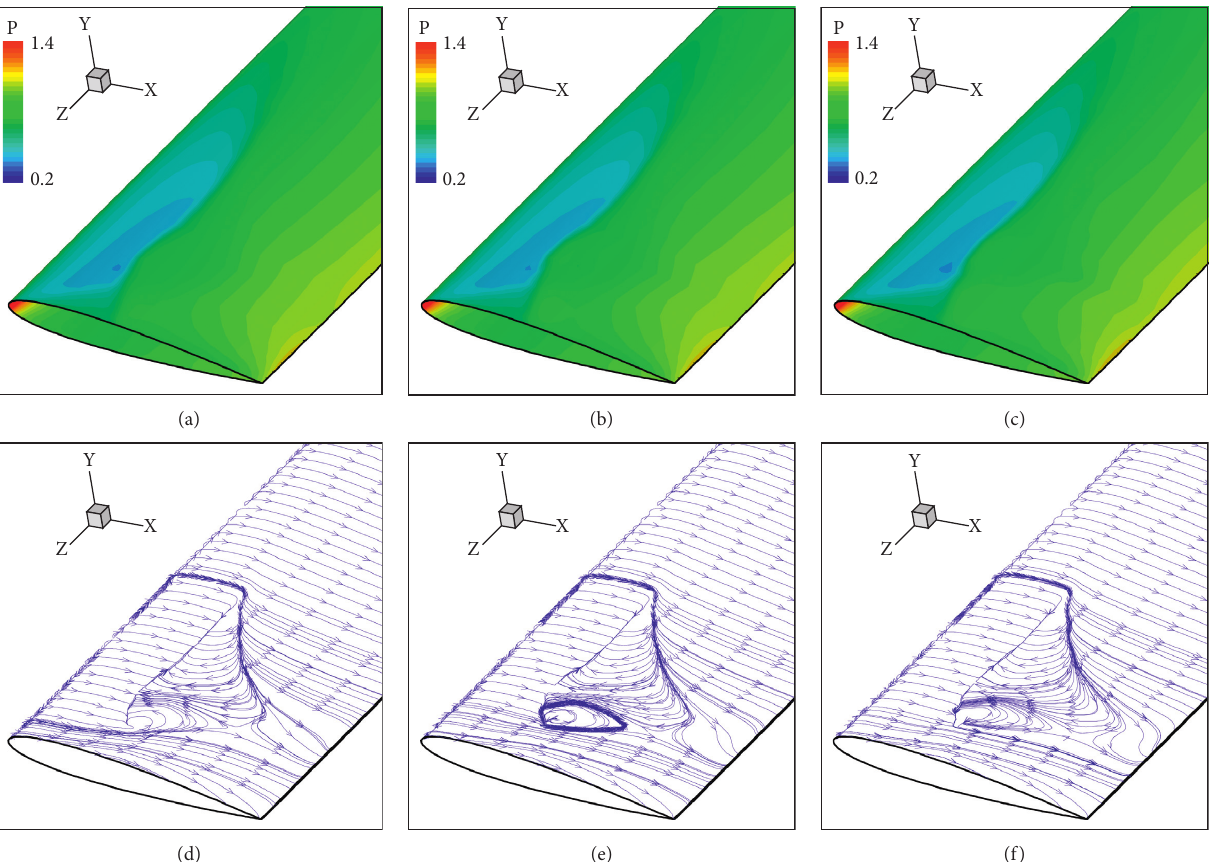
Figure 18: Pressure contours and streamlines with three WENO schemes on the blade surface for the Caradonna-Tung rotor. (a) WENO-JS. (b) WENO-Z. (c) WENO-NZ. (d) WENO-JS. (e) WENO-Z. (f)